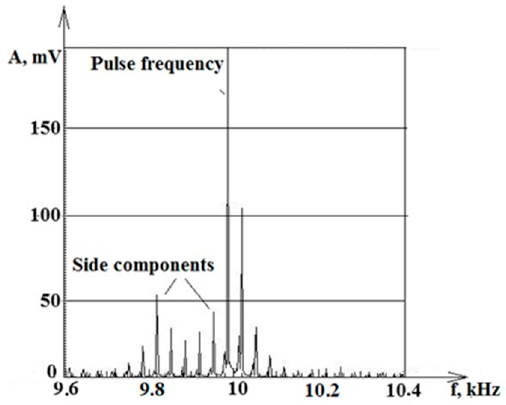
Figure 6. Examples of the VA signal recording in a spectrum range of 9.5–10.5 kHz under pulsed laser exposure. laser